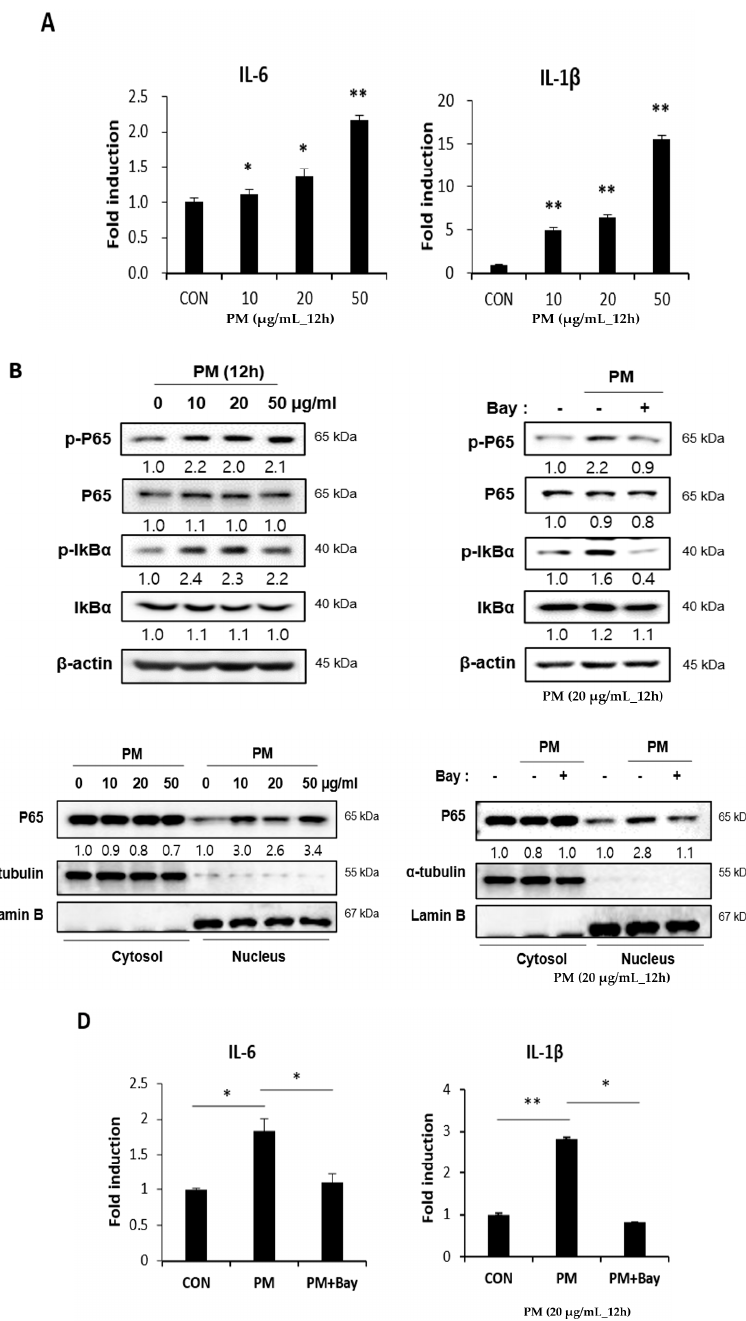
Figure 2. PM induces pro-inflammatory cytokines through the NF- κ B signaling pathway. ( A ) The mRNA levels of IL-6 and IL-1 β were verified by RT-PCR. PM increased the mRNA expression of IL-6 and IL-1 β . ( B ) The expression of proteins associated with the NF- κ B signaling pathway was evaluated by Western blot. The expression of p-P65 and p-I κ B α increased significantly with the PM treatment. Cells were treated with various concentrations of PM (0–50 µ g / mL) for 12 h. Increased expression of the protein associated with NF- κ B signaling pathway activation was reduced by NF- κ B inhibition (Bay 11-7082). ( C ) The expression of P65 in the cytoplasm and the nucleus. The translocation from the cytoplasm to the nucleus was increased after the PM treatment. Cells were treated with various concentrations of PM (0–50 µ g / mL) for 12 h. The translocation from the cytoplasm to the nucleus was reduced by NF- κ B inhibition. ( D ) The increased mRNA expression of IL-6 and IL-1 β was reduced significantly by NF- κ B inhibition (Bay 11-7082). Cells were treated with PM (20 µ g / mL) for 12 h. * p < 0.05, ** p <